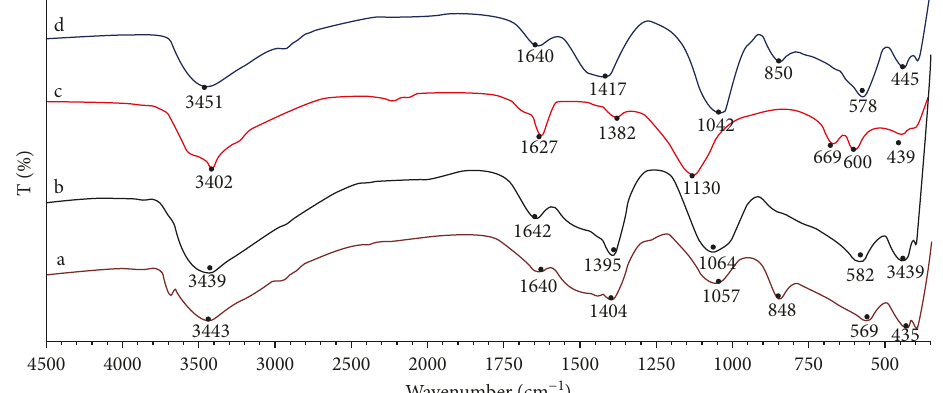
Figure 1: FTIR spectra of the as-synthesized layered double hydroxides: (a) Mg-Al(OH) (OH) 2 SO 4 ( 3 ), and (d) Ca-Al(OH) 2 PO 4 PF 6 ( 4 ).